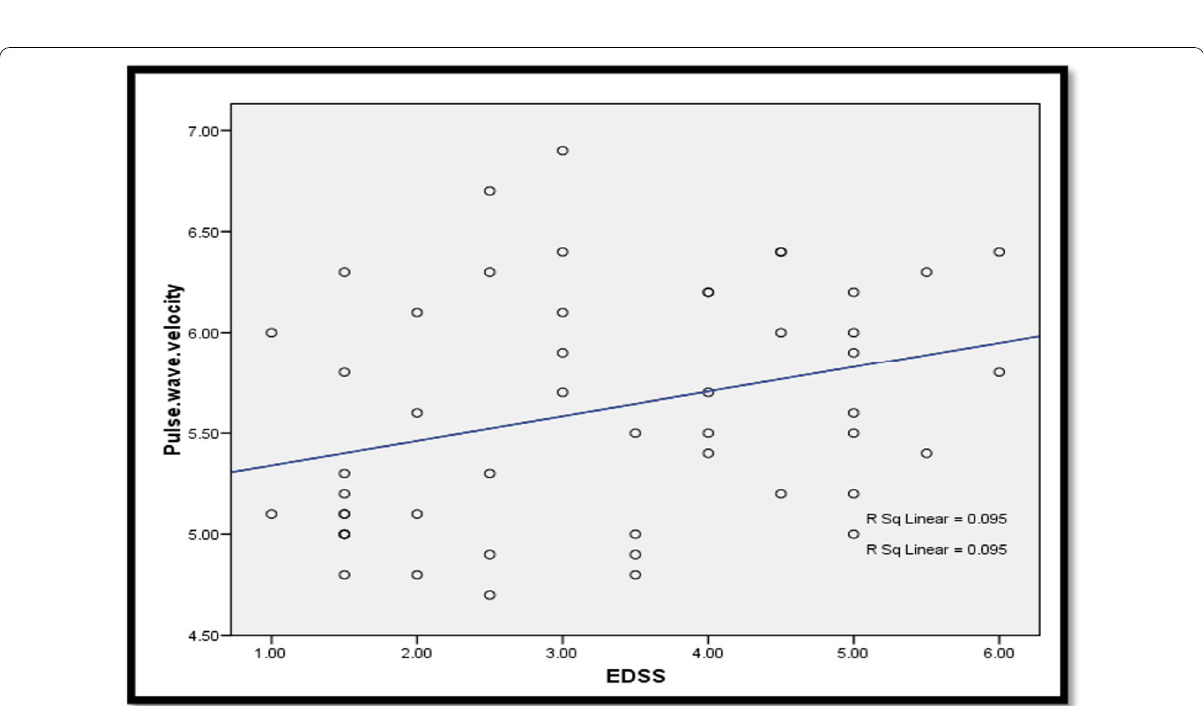
Fig. 2 Correlation between EDSS and peripheral PWV (m/s). EDSS, Expanded Disability Status Scale; PWV, pulse wave